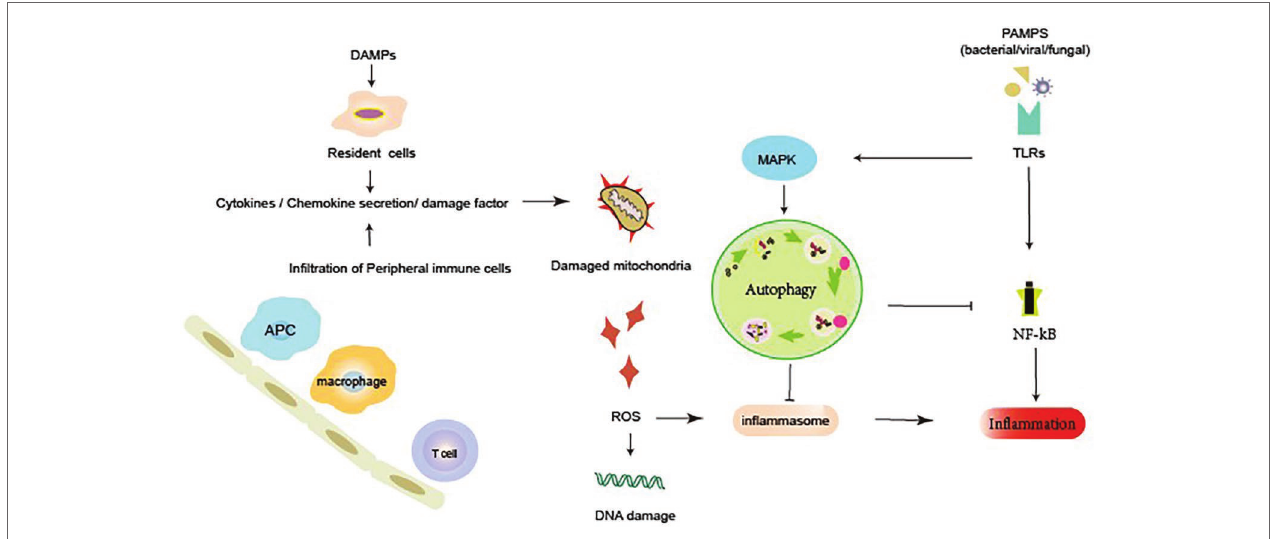
FIGURE 2 | Autophagy and inflammatory response during acute kidney injury (AKI). Renal dysfunction during AKI may result from the external or internal signals involving PRRs, chemokines, cytokines, and ROS. Autophagy can elicit a dynamic response to inflammation. Active autophagy prevents an excessive inflammatory response by preventing the inflammasome activation, mediating the clearance of DAMPs and damaged mitochondria, and degrading inflammatory mediators. DAMP, damage-associated molecular pattern; PAMP, pathogen-associated molecular pattern; PRR, pattern recognition receptors; MAPK, mitogen-activated protein kinase; NF- κ B, nuclear factor kappa b; ROS, reactive oxygen species; TLRs, membrane-associated toll-like